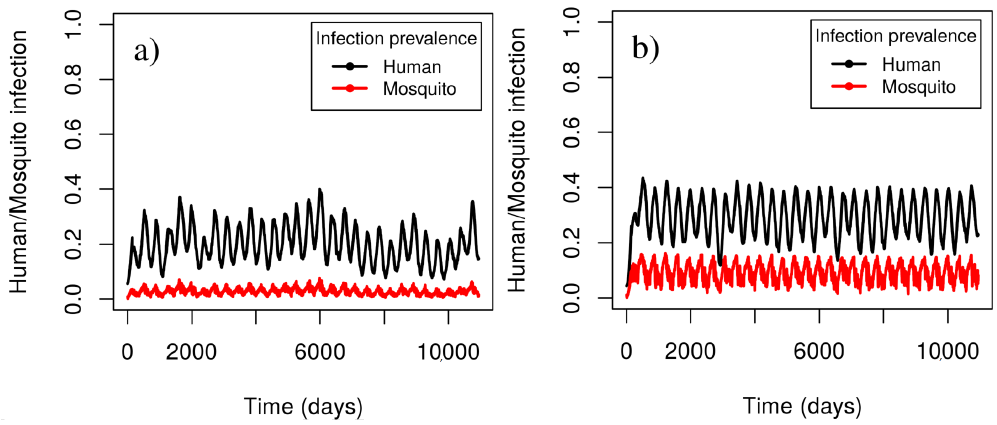
Figure 1. Human and mosquito infection prevalence ( a ) in a scenario of homogeneous affinity, namely 20% of the human individuals receive 20% of mosquitoes bites, and ( b ) in a heterogeneous scenario when 20% of the human individuals receive 80% of mosquitoes bites. In both cases, intermediate human-to-mosquito transmission efficiency is considered, w h =